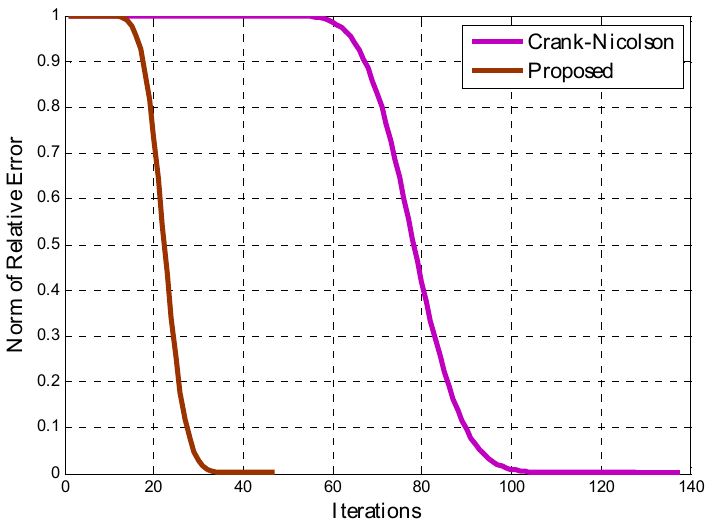
Figure 3. Comparison of speed of convergence of two schemes using 𝑁 (cid:3051) = 40,𝑁 (cid:3047) = 520, 𝐿 = 𝜋, 𝑡 (cid:3033) = 1 .